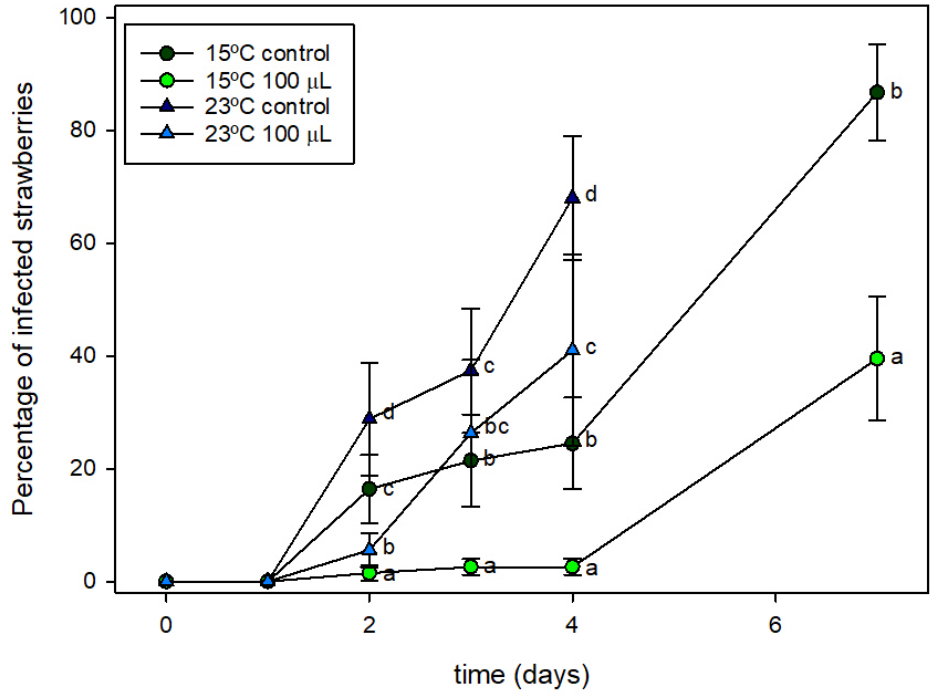
Figure 6. Effect of active component on the fungal decay of strawberries. Percentage of infected fruits per package in the control and active packages (with 100 µL of HXAL) in conditions of thermal abuse (15 °C and 23 °C). a,b,c,d : different letters indicate that there are significant differences between samples or conditions ( α < 0.05).